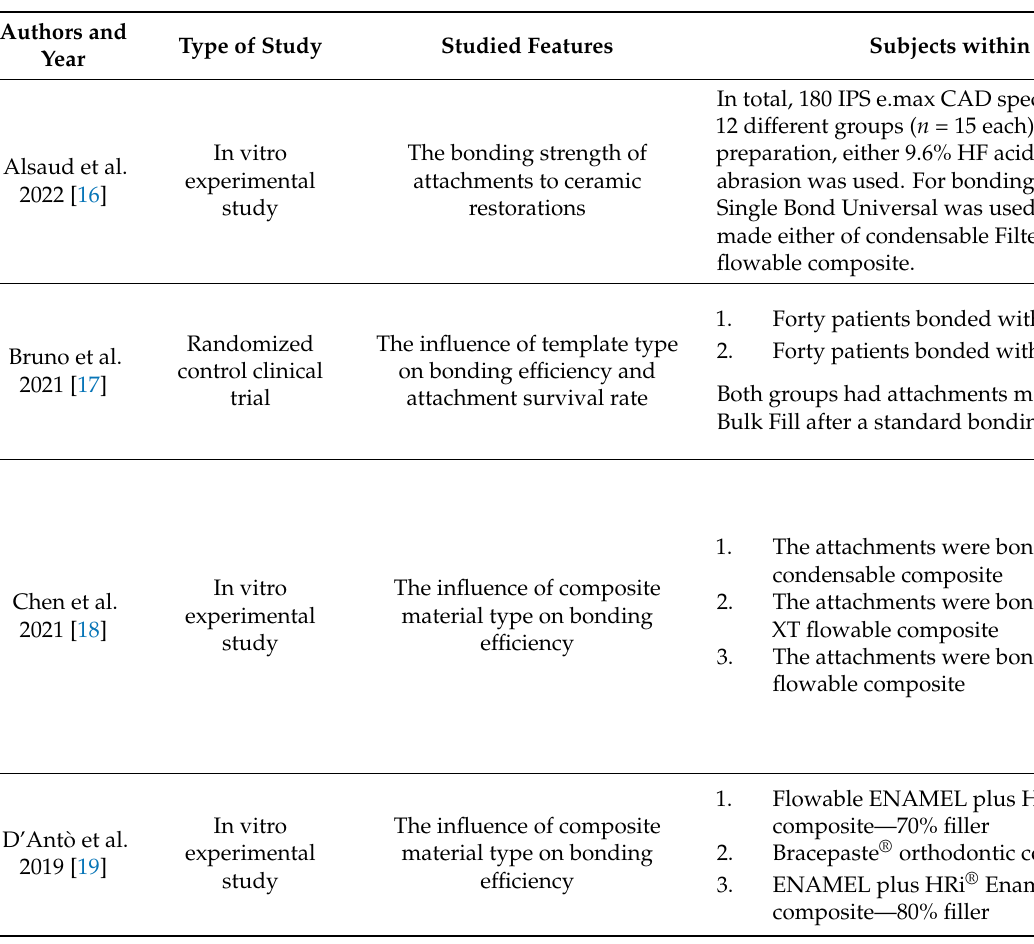
Table 1. Included studies regarding bonding